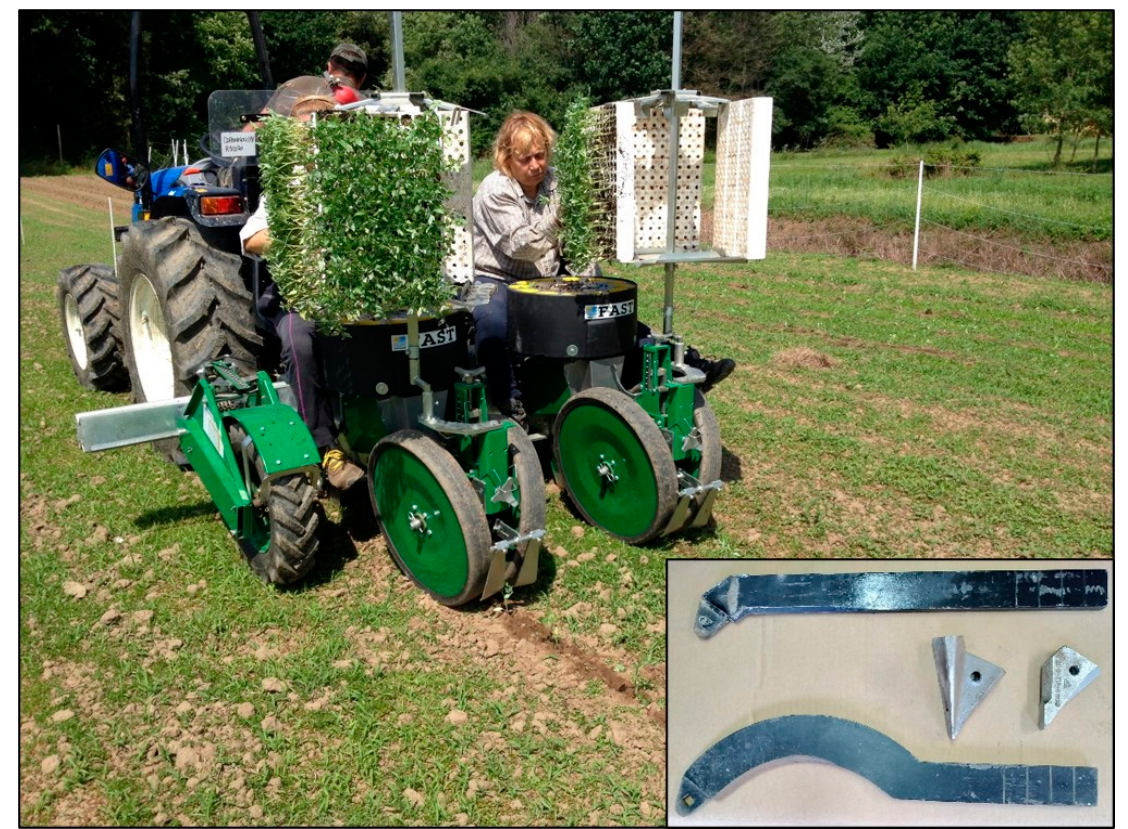
Figure 2. Two-row no-till transplanter realized at the University of Pisa and details of the two shanks opener and points used.